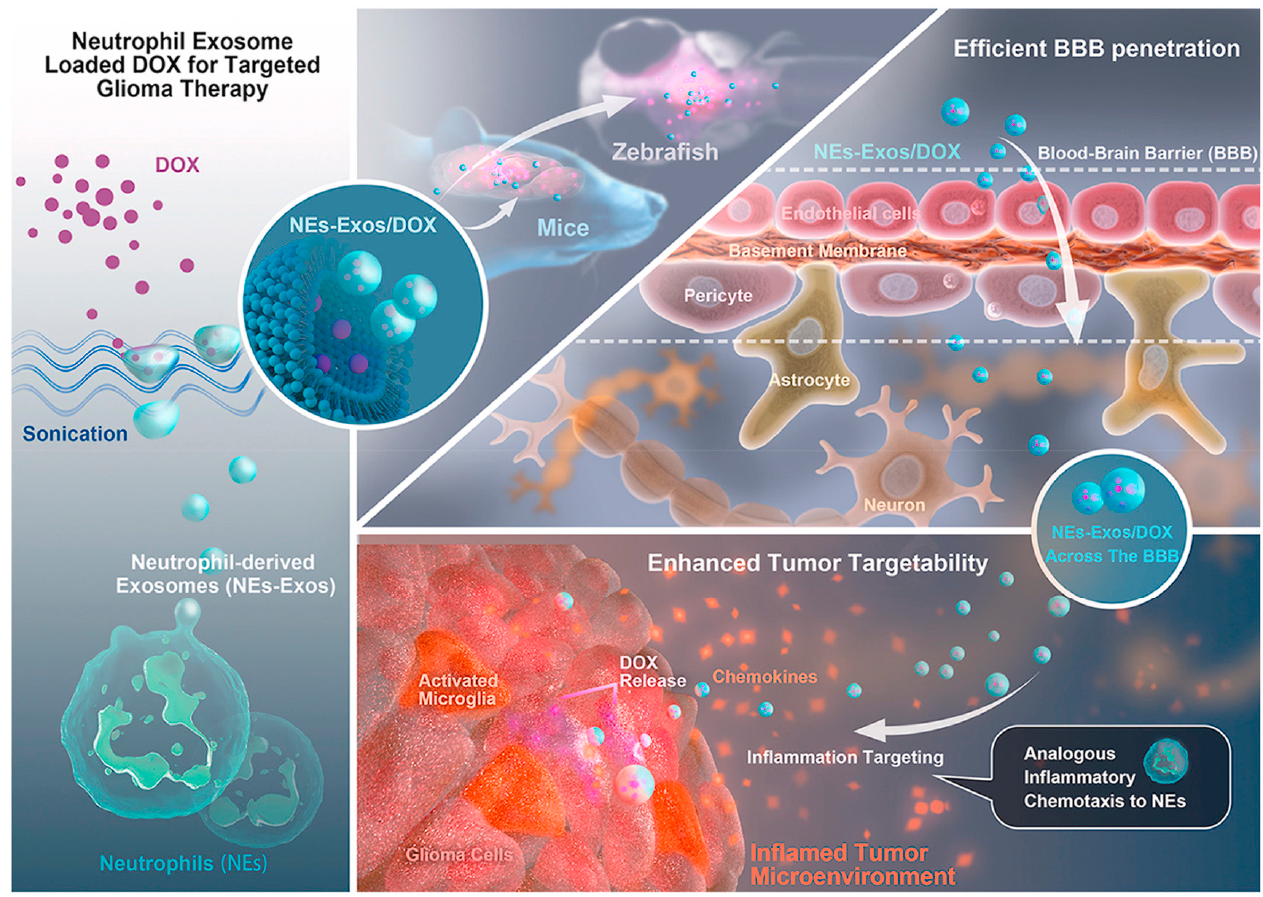
Figure 13. Schematic representation of doxorubicin loading into neutrophil-exosomes, BBB crossing of the nanosystem, and inflammatory stimuli-responsive drug delivery. Reprinted with permission from [149]. Copyright 2021, Elsevier. Abbreviations: BBB—blood-brain barrier; DOX—doxorubicin.